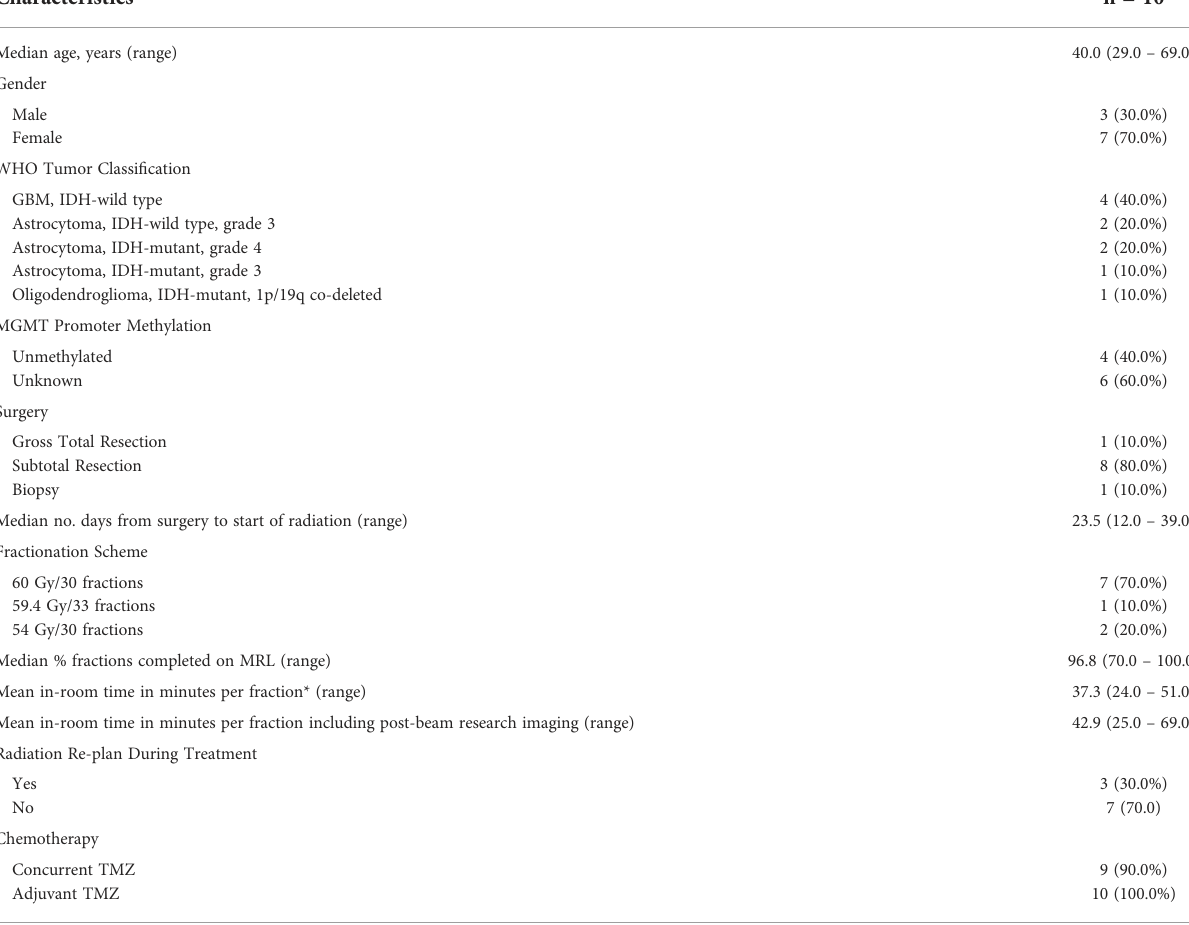
TABLE 1 Summary of patient, tumor and treatment